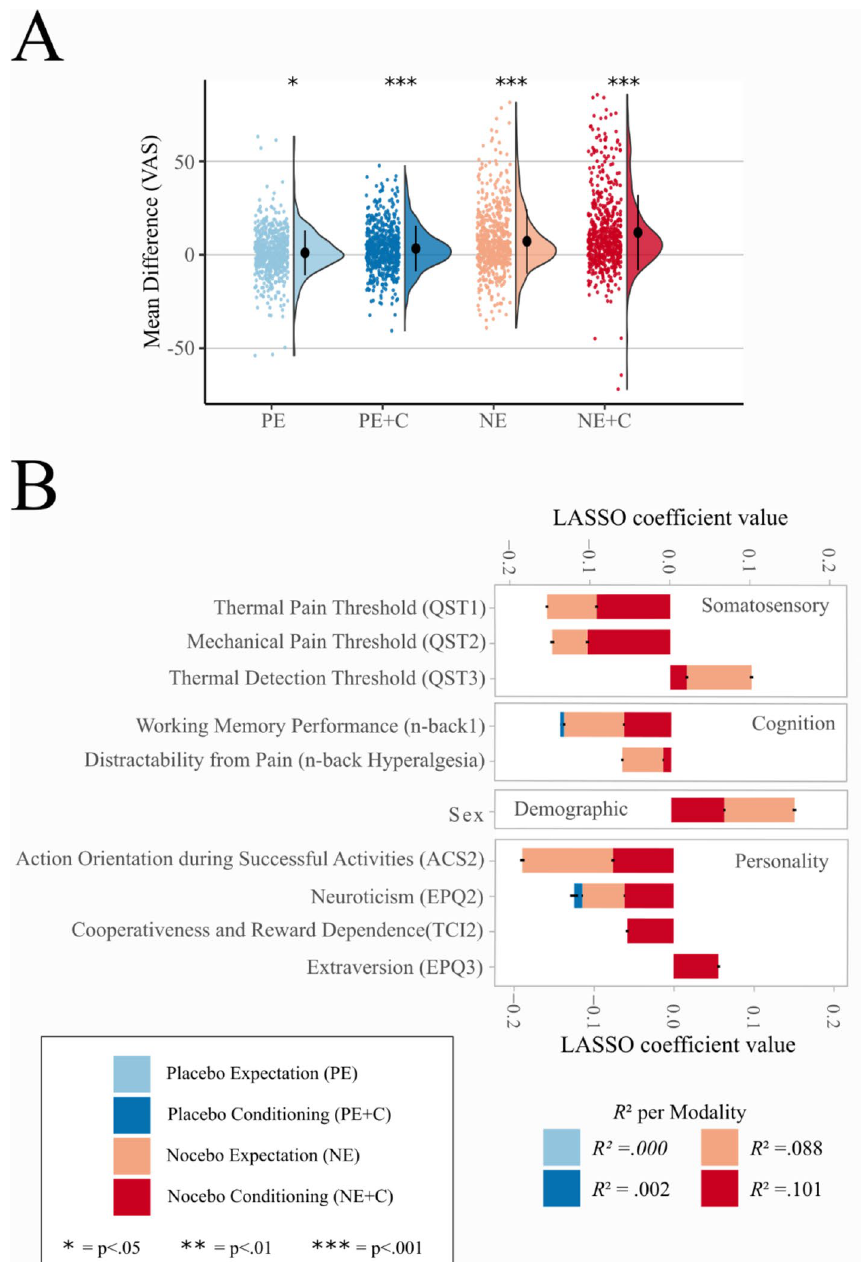
Figure 2. Main effects and LASSO analysis. ( A ) Group mean of placebo and nocebo effects (difference between sham treatment and control). The colored dots on the left represent raw jittered data of individual participants. The half-violin plots on the right represent the distribution of the data. The black dot represents the group mean and the error bars represent the standard deviation. The figure is color-coded for: Placebo Expectation (PE), Placebo Conditioning (PE + C), Nocebo Expectation (NE), Nocebo Conditioning (NE + C). ( B ) LASSO results. The stacked bar plots display the ten best LASSO coefficients for each modality with standard deviations of 1000 iterations. Variables are ordered by variable subgroup and within these subgroups ranked by summed overall